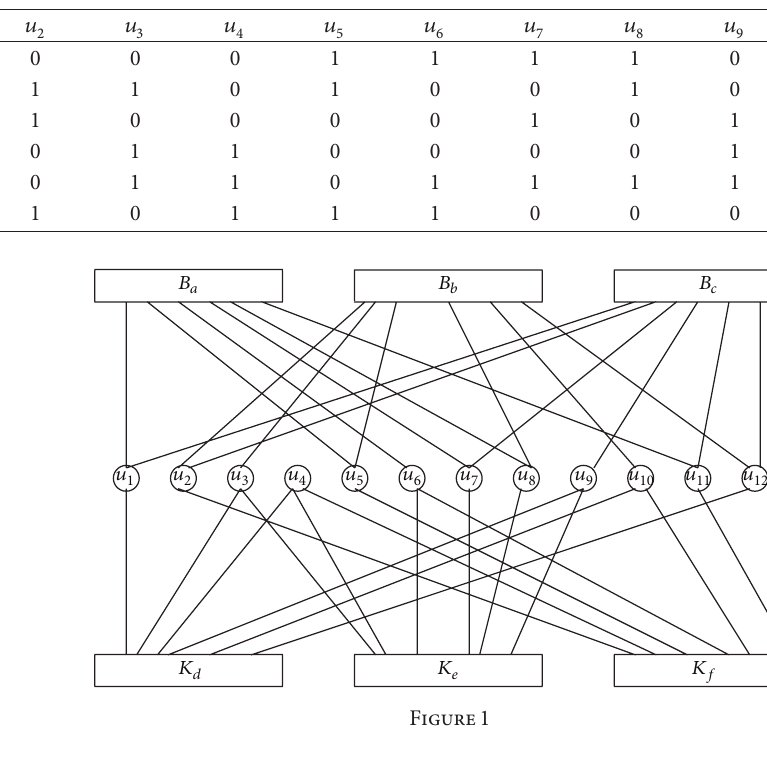
Table 1: The teacher-student interactive platform (𝑈; B )